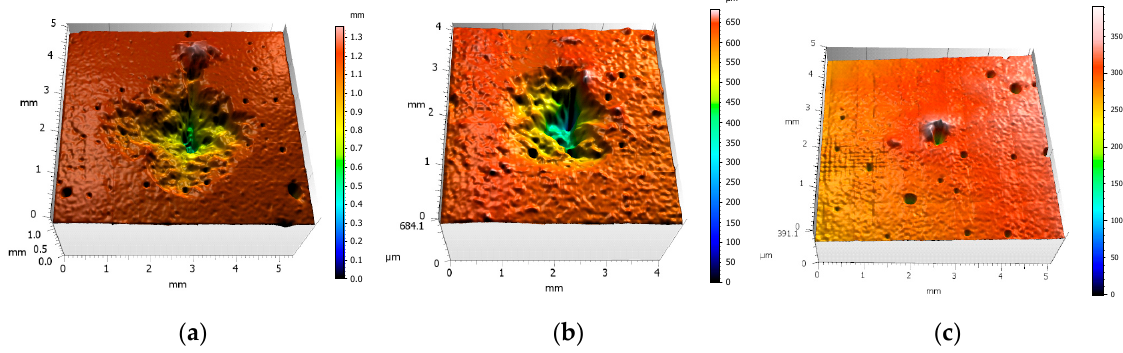
Figure 10. “Breakout cone” of 30°- ( a ), 60°- ( b ), and 90°-orientated ( c ) steel fibres after monotonic loading.